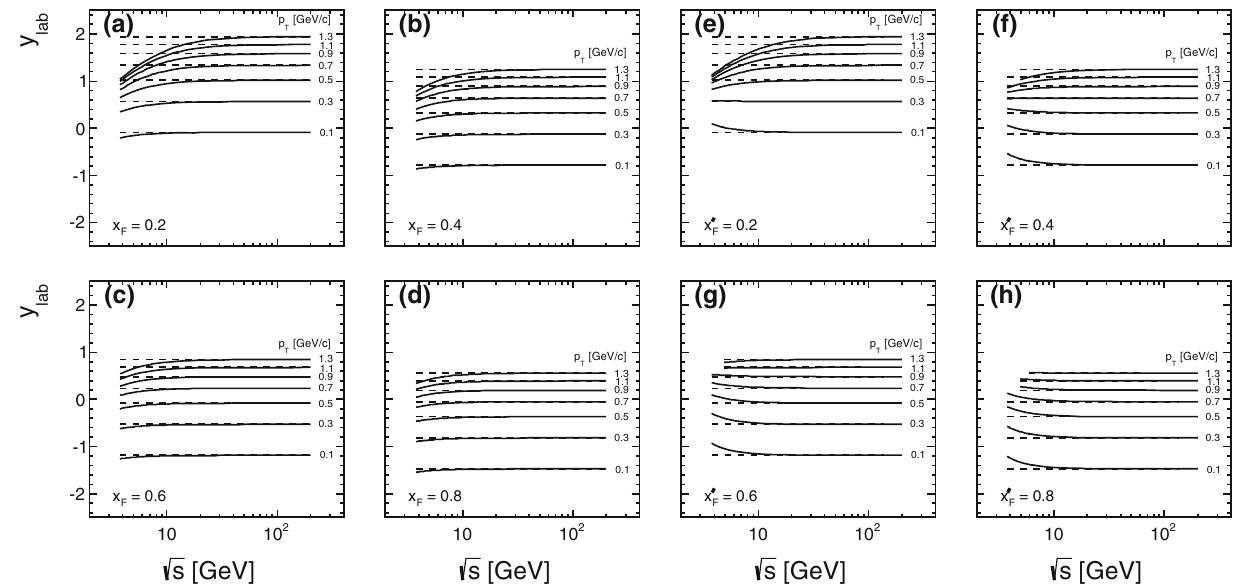
√ s for different values of x F / x (cid:3)